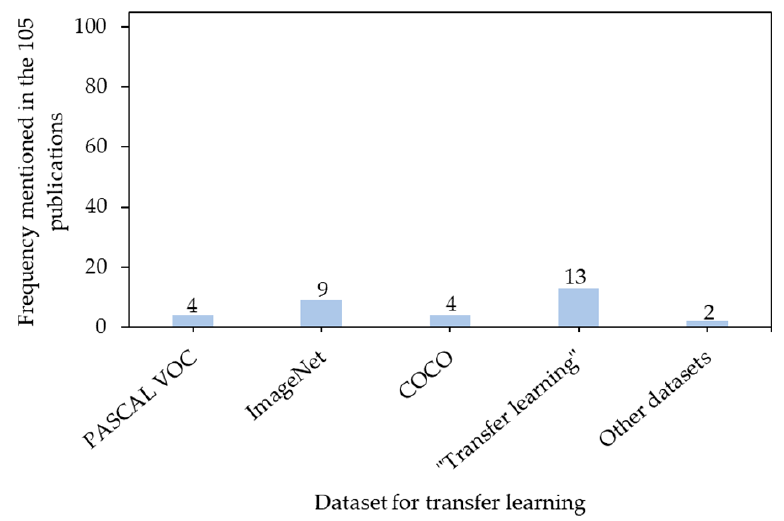
Figure 10. Frequency of different datasets mentioned in the 105 publications. PASCAL VOC is PASCAL visual object class. COCO is common objects in context. “Transfer learning” means the publications only mentioned “transfer learning” rather than specified datasets for transfer learning. Other datasets are motion analysis and re-identification set (MARS) and action recognition dataset (UCF101).